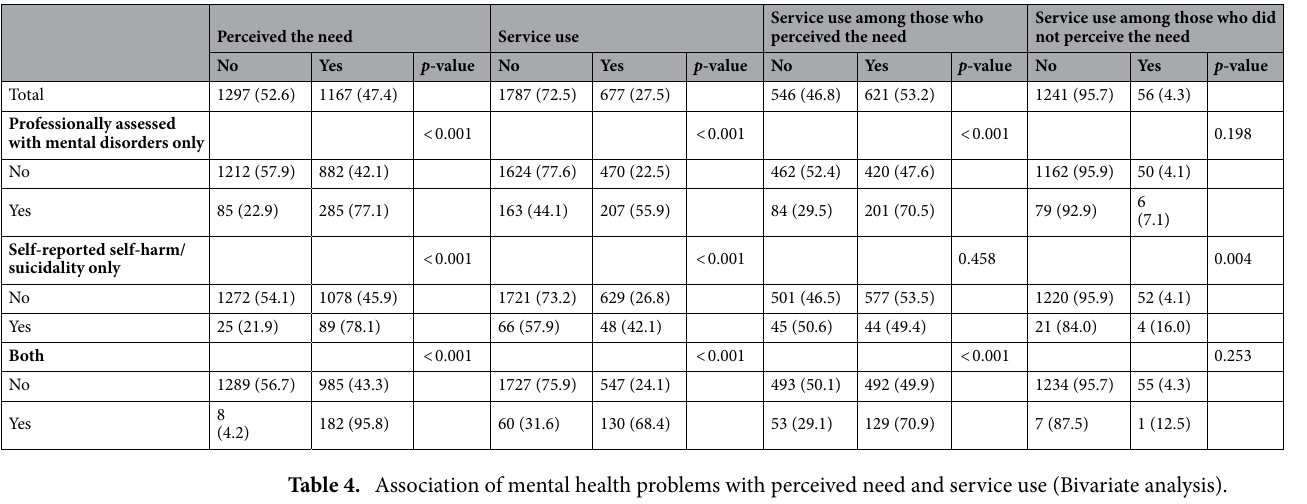
Table 4. Association of mental health problems with perceived need and service use (Bivariate